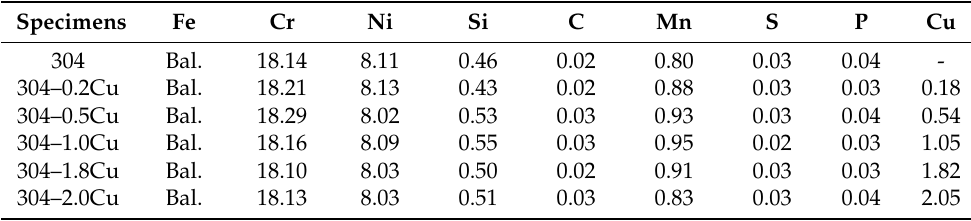
Table 1. Chemical composition (wt%) of the experimental Cu-bearing 304 stainless steel. Specimens Fe Cr Ni Si